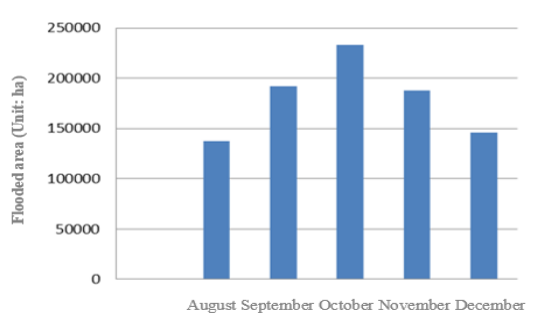
Figure 3: Flooding area in the LXQ region in five months from August to December